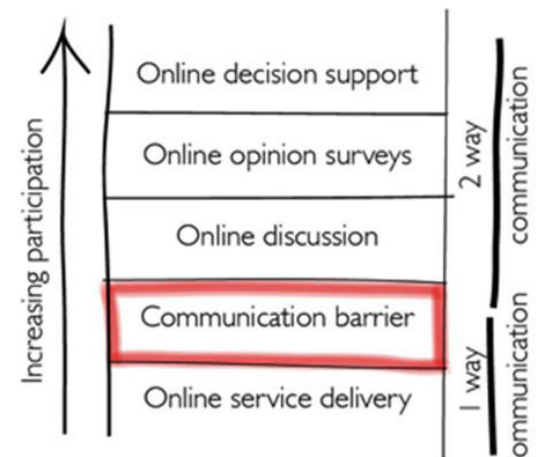
Figure 1. Smyth’s (2001) ladder of e -participation.